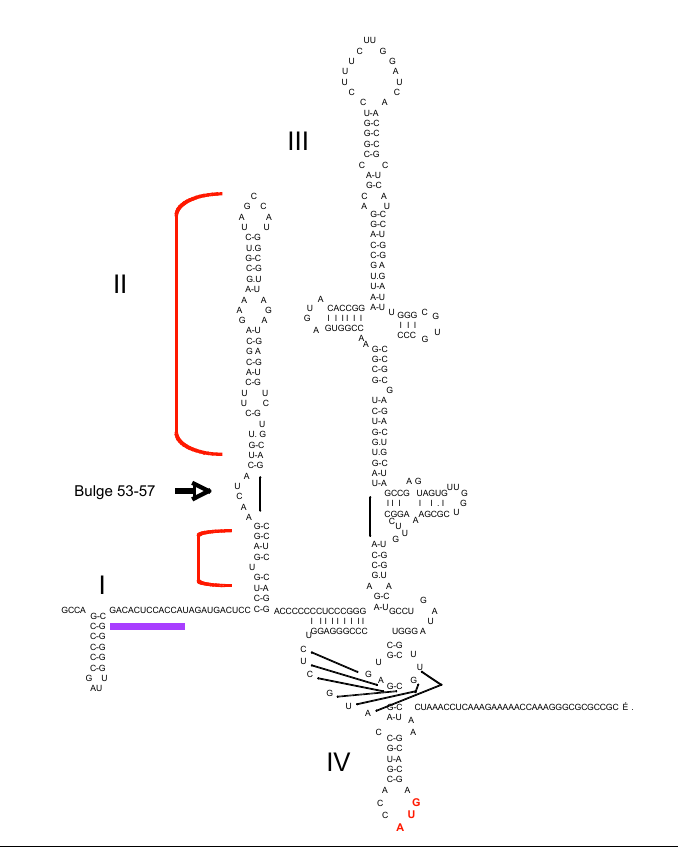
Figure 4. PKR and the HCV IRES. Secondary structure of the Internal Ribosomal Entry site (IRES), located within the first 388 nucleotides of HCV RNA. The four stem-loop domains of the IRES are numbered in Roman numerals (I, II, III and IV). The binding site for miR122 is underlined (purple). The brackets (in red), located on each side of a 53–57 bulge (arrow) indicate the protected areas from ribonuclease or 2' hydroxyl attack when PKR is present.